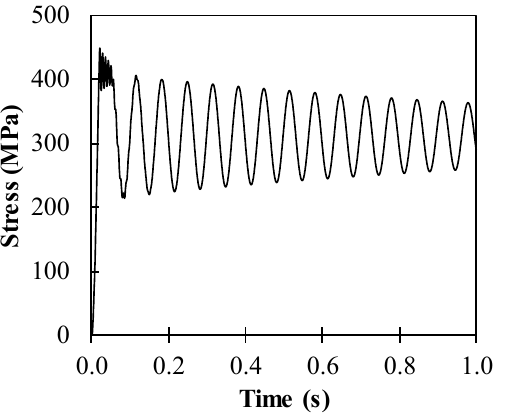
Figure 15. Stress evolution in CFRP of the optimized hybrid system containing 8.2 mm thick steel slab and 7.0 mm thick ϕ 100 mm CFRP frame.